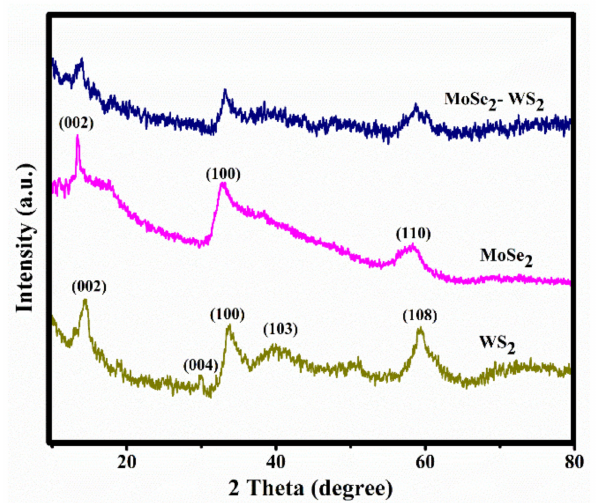
Figure 1. XRD patterns of pristine WS 2 and MoSe 2 , and nanostructured MoSe 2 -WS 2 composite. Spectra were recorded using a CuK α X-ray source ( λ = 1.5406